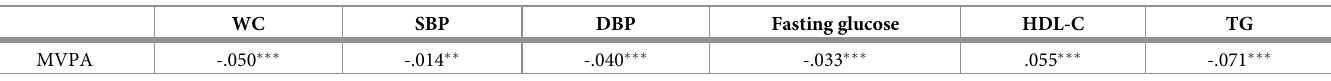
Table 5. Pearson’s correlation coefficients (n =